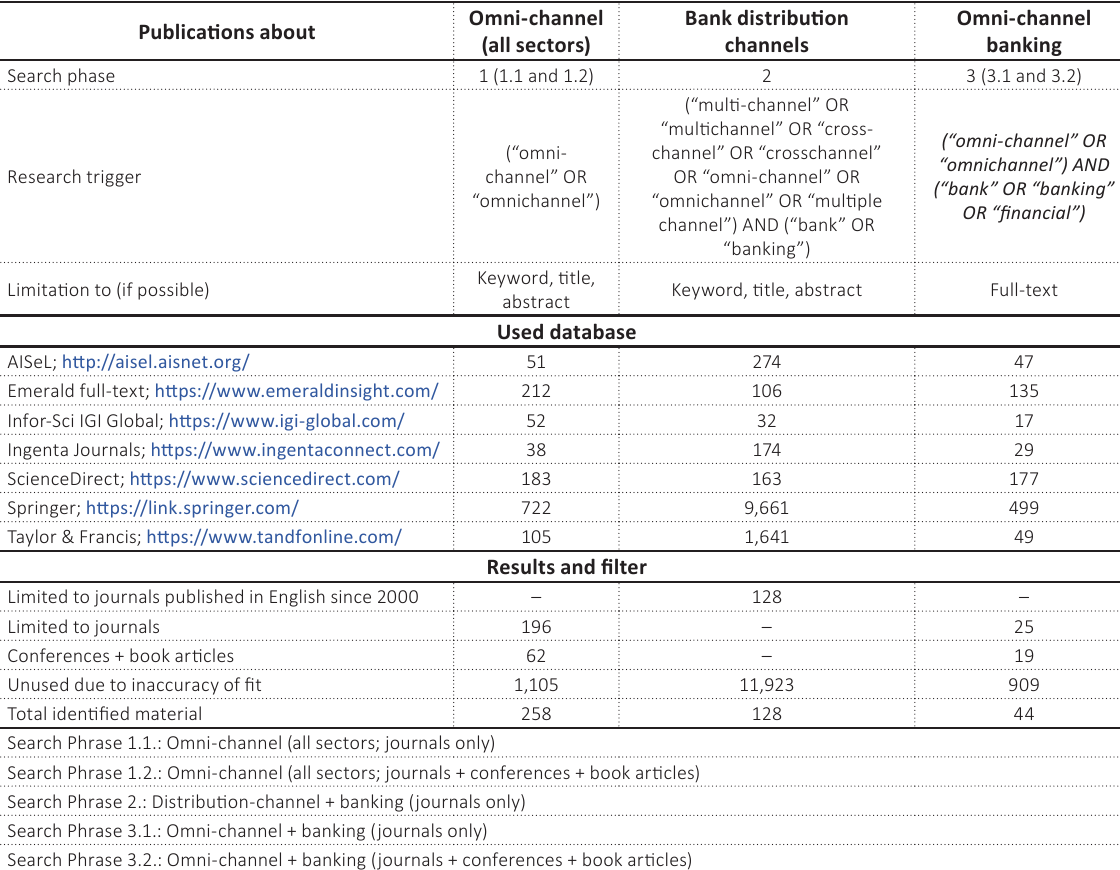
Table 4. Results of literature